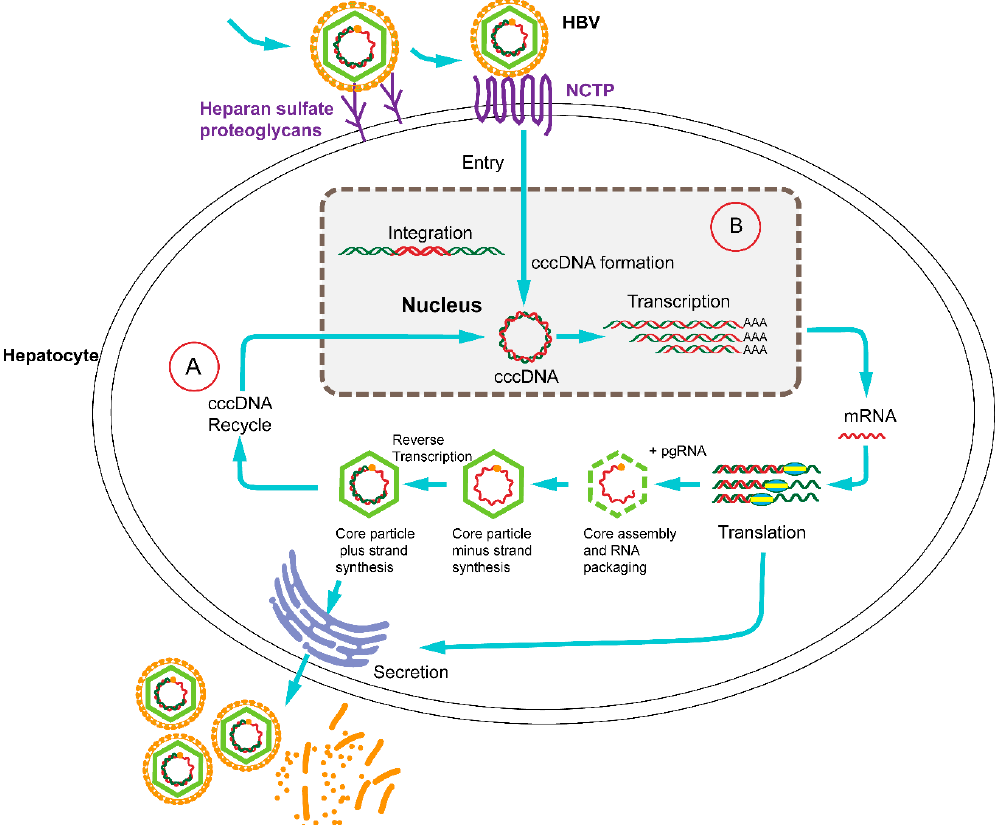
Figure 1. The life cycle of hepatitis B virus (HBV) with therapeutic targets. HBV binds to surface receptors and enters the hepatocyte. Viral particles migrate to the cell nucleus, where the